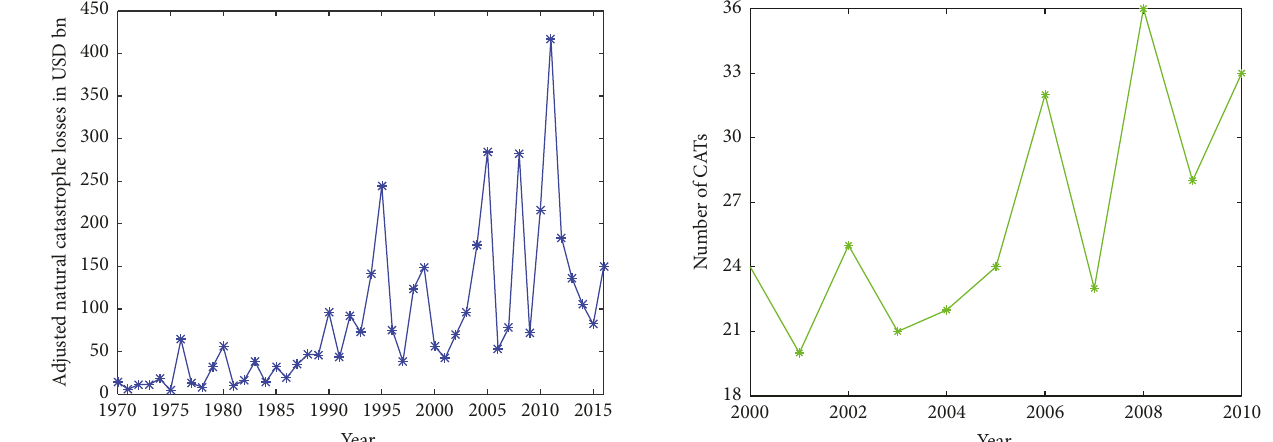
Figure 4: Number of natural CATs in the United States from 2001 to 2010.